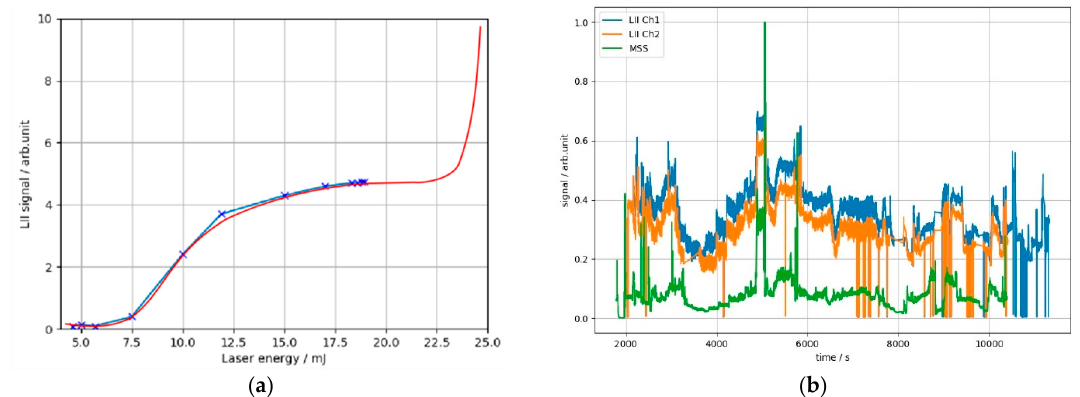
Figure 1. Measurement data collected with our LII system ( a ) a qualitative comparison of the LII signal at different laser energies with results from [2]; ( b ) raw data from the measurements on the engine testbed, with an AVL MSS as reference, showing an excellent qualitative